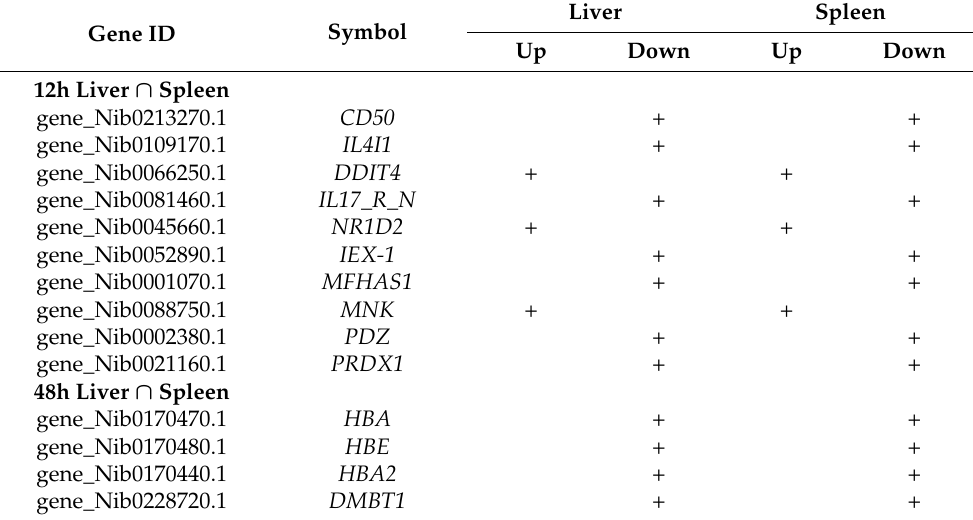
Table 3. The Shared Differentially Expressed Gene Information of Different Tissues at the Same Time.